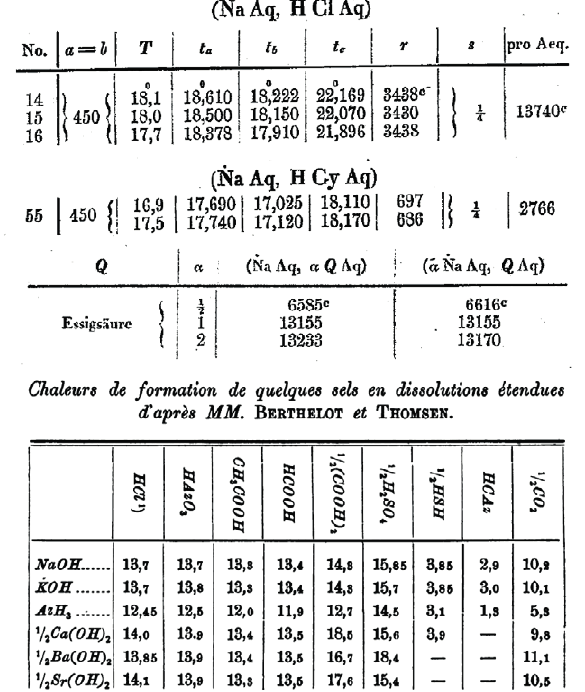
Table 2. Heats of neutralization for different acids and bases. Upper panel: Thomsen´s values from 1869 and 1870 for the monobasic hydrochloric, hydrocyanic and acetic acid. T; temperature in °C. α; number of equivalent base added to 1 equivalent acid. Concen- trations: varying, typically 1 eq. in 200 or 400 L water. Taken from refs. [79, 82] . Lower panel: Table from Berthelot´s 1879 book which was reproduced by Arrhenius in his dissertation, Part 2, p. 68. 1